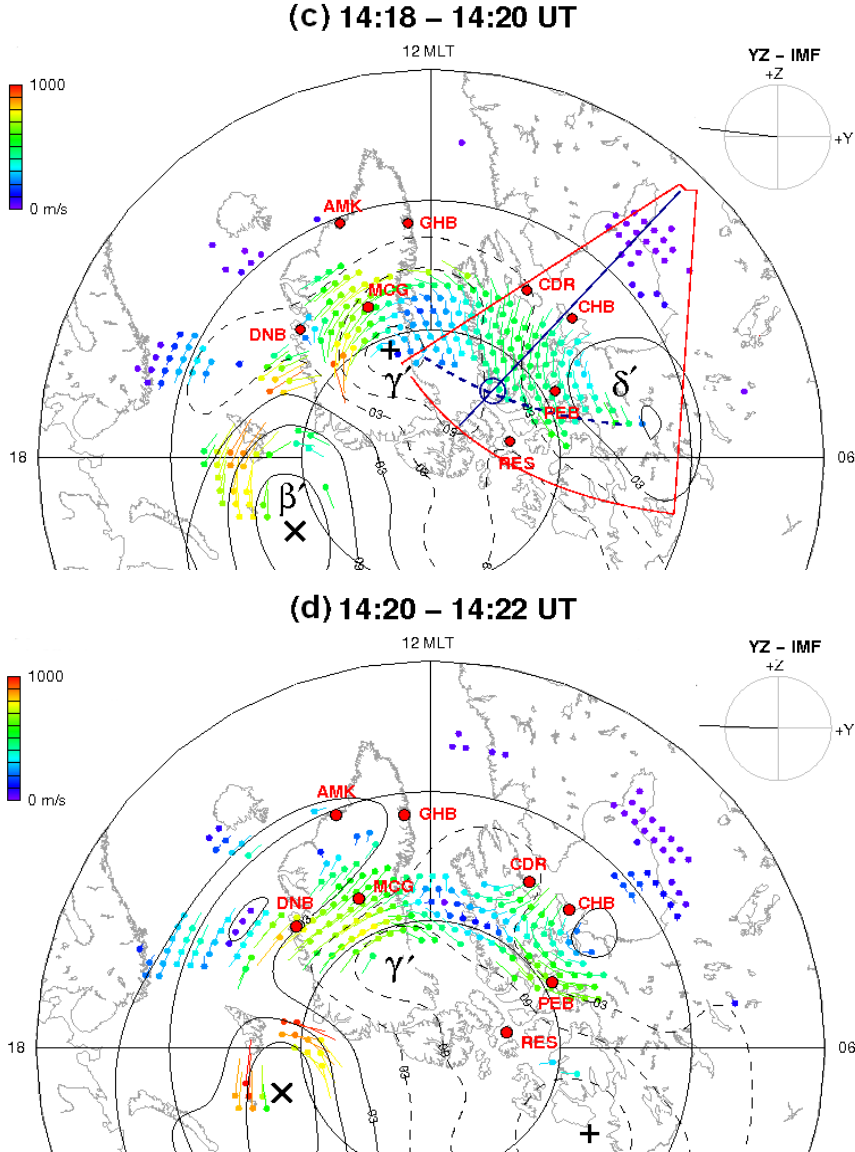
Fig. 6. Continued. Northern Hemisphere SuperDARN convection maps for 6 January 1998, between 14:18 and 14:22UT. In panel (c) , the field of view of Kapuskasing is also shown: the thick blue line evidence the direction of beam 11, the blue circle represents the region where the beam is supposed to cross the merging line footprint (see text), and the blue dotted curve represents a tentative merging line footprint. a series of magnetic transients is observed in the morning around 75 ◦ MLAT starting from 14:24 UT, up to 14:40